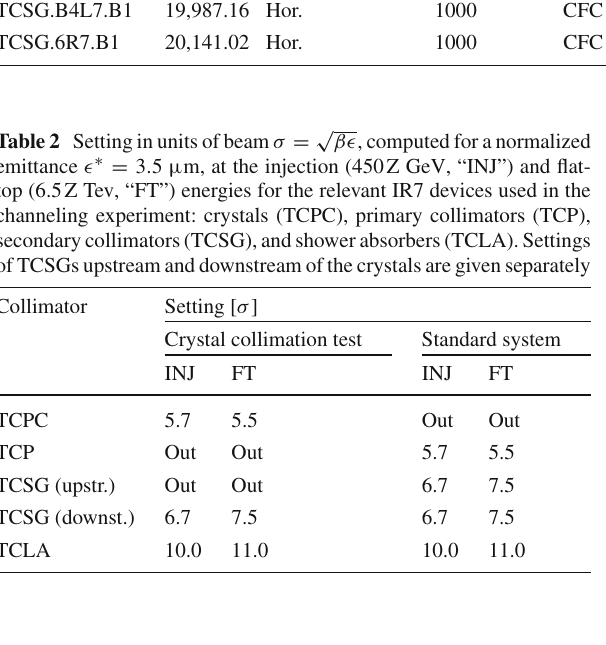
Table1 Installationposition,collimationplaneandmainopticsparam- eters for the crystal devices (TCPC) and secondary collimators (TCSG) used as absorbers for the channeled halo. Nominal optics parameters